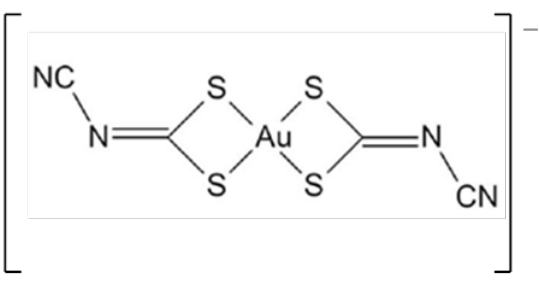
Figure 1. Molecular structure of [Au(cdc) 2 ] − (cdc = cyanodithioimido carbonate).